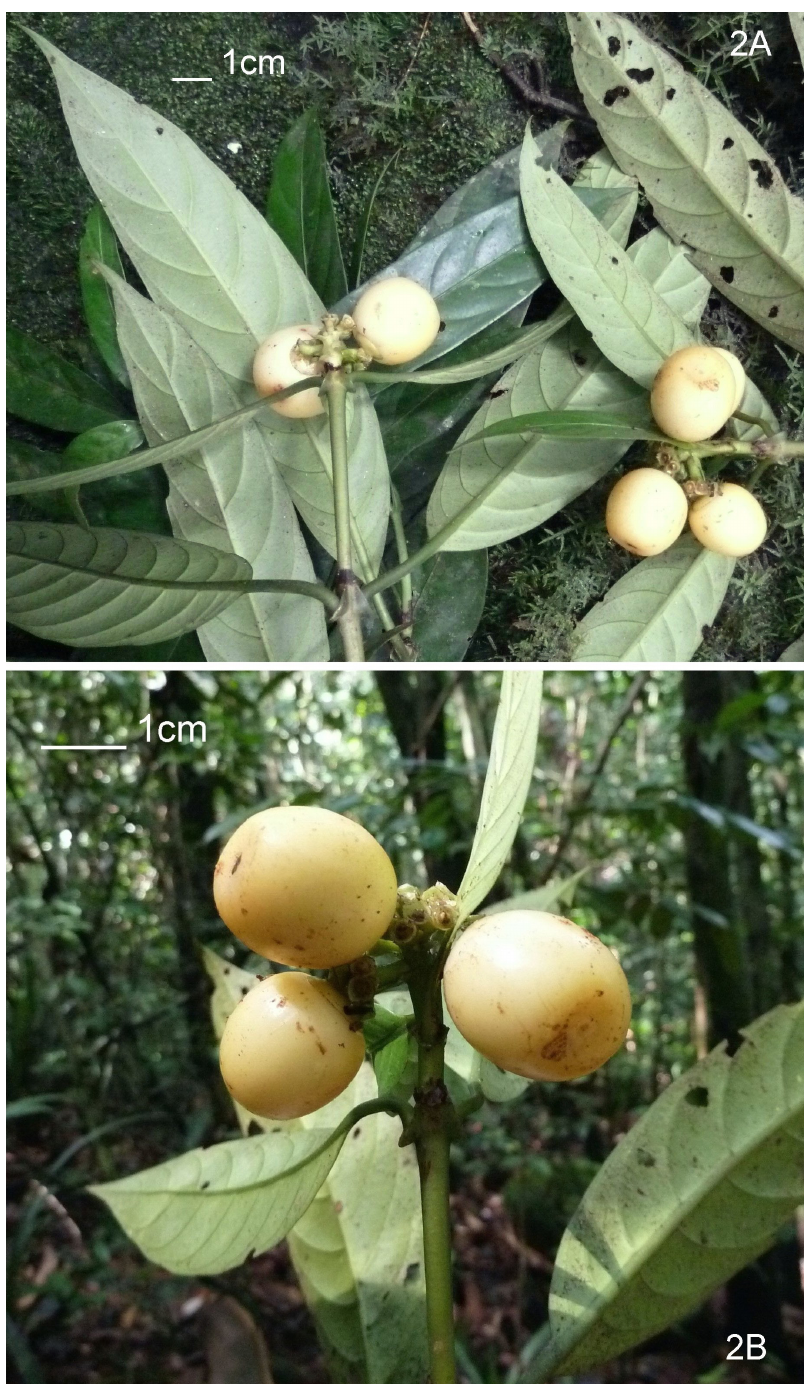
Fig. 2. Gaertnera luteocarpa sp. nov. subsp. sinoensis subsp. nov. A . Fruits and leaves. B . Close up of fruits. From Jongkind, Bilivogui & Daniels 9832 . Photos C.C.H.